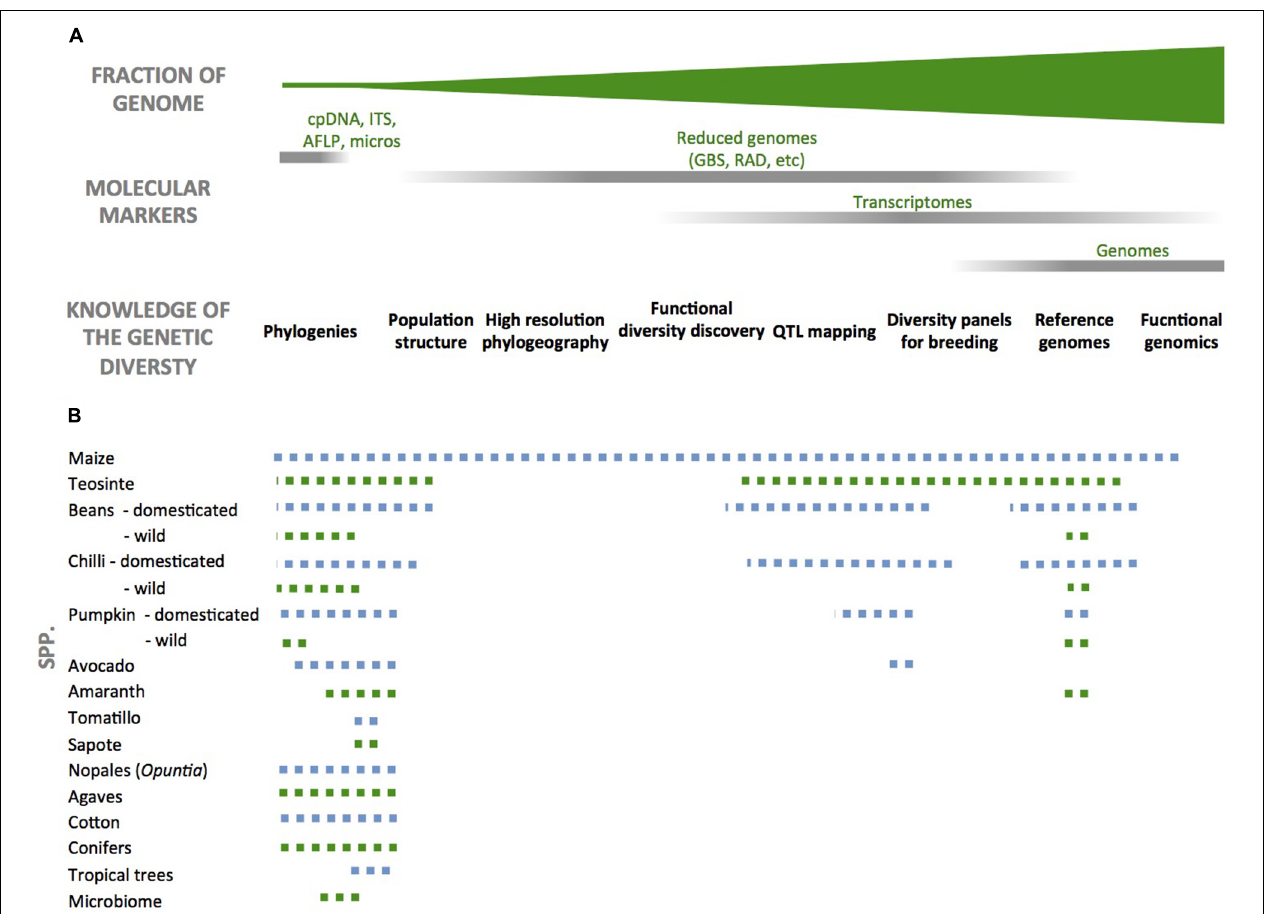
FIGURE 1 | Current state of knowledge on the genetic diversity of Mexican crop and forestry species. (A) Top to bottom: fraction of the genome (green triangle) that is represented by different molecular markers (gray bars) and below the kind of knowledge these are used for. (B) Dashed lines represent the types of studies that have been developed for each species according to the markers and topics from the top. The size of the line is an approximate representation for the level of current knowledge for each species. Differences in line color are only for visual